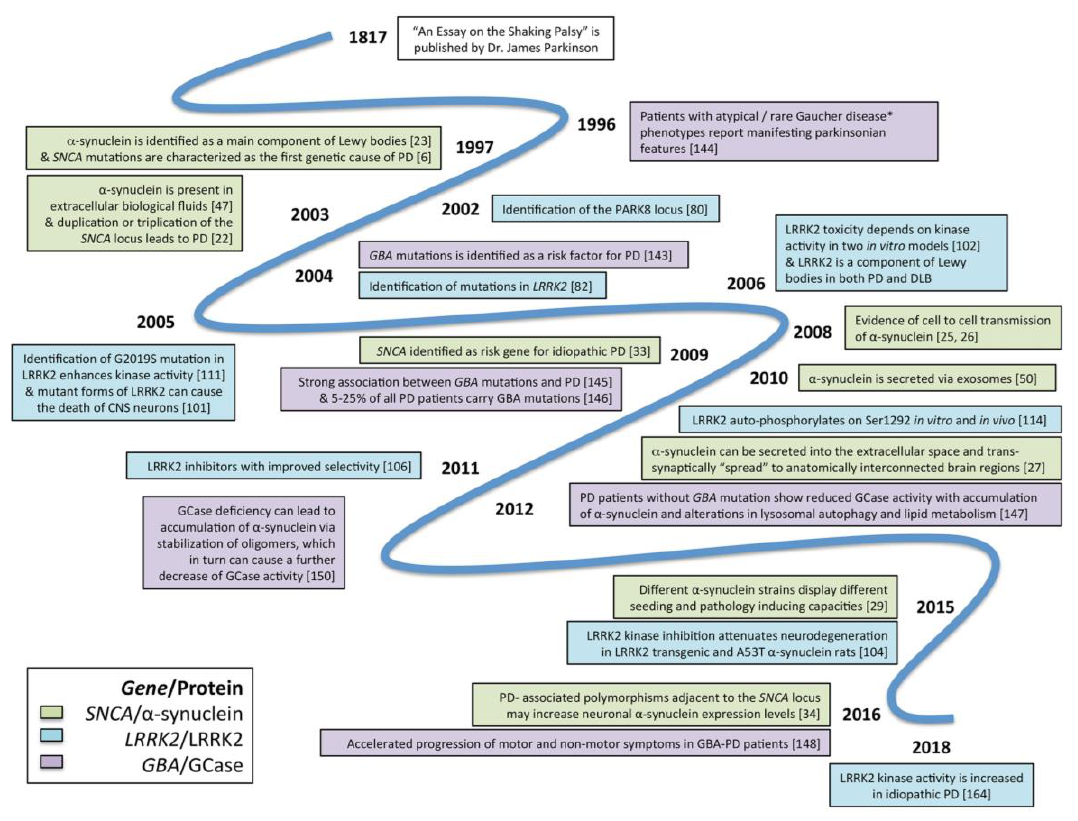
Figure 1. Timeline of milestone discoveries related to the three main genetic PD targets; a-synuclein, LRRK2 and GBA. DLB, Dementia with Lewy bodies; GBA, P-Glucocerebrosidase {Gcase) gene; LRRK2, Leucine—rich repeat kinase 2; PD, Parkinson’s disease; SNCA, α -synuclein gene; * Gaucher disease is a lysosomal storage disorder caused by biallelic GBA mutations.